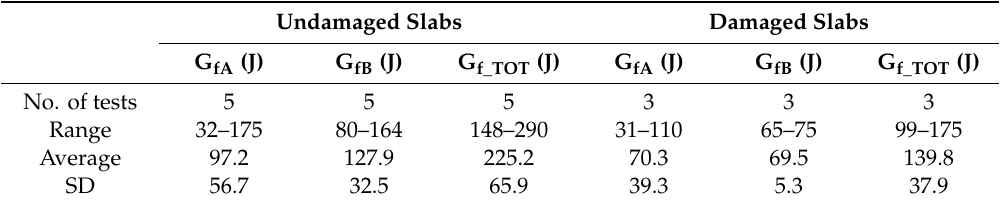
Table 7. Fracture energy average value and standard deviation.